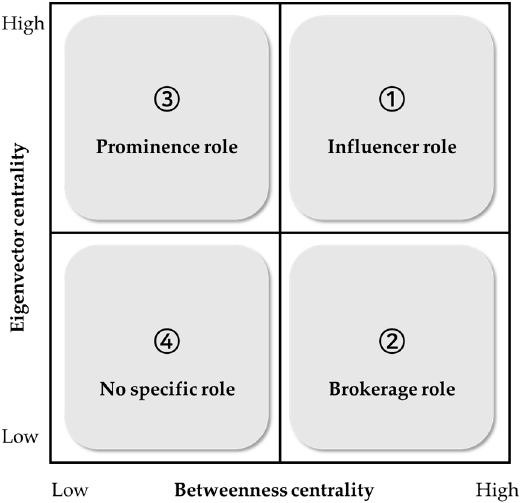
Figure 3. Matrix model for the classification of knowledge areas. (Note: The x-axis represents the betweenness centrality, while the y-axis represents the eigenvector centrality).